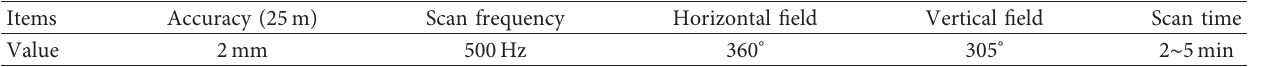
Table 2: FARO Focus 3D parameter indicators.